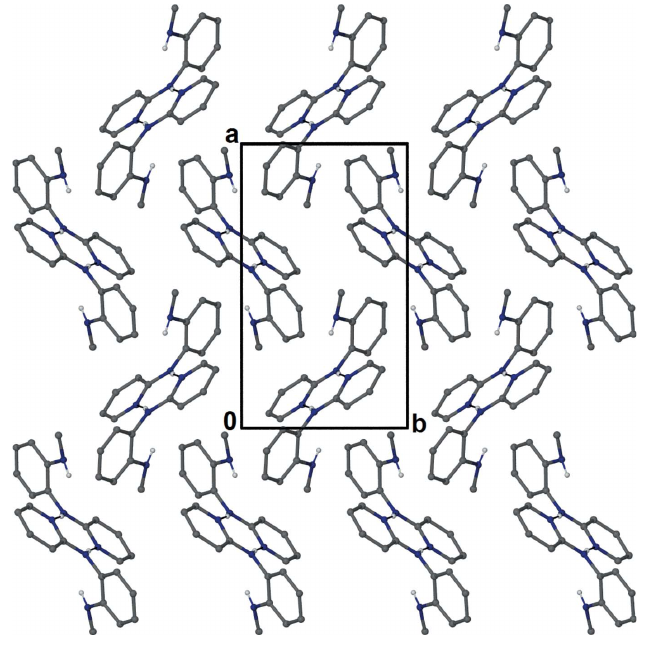
Figure 3 A view of the unit-cell packing, showing a single 2-D layer of hydrogen- bonded dimer